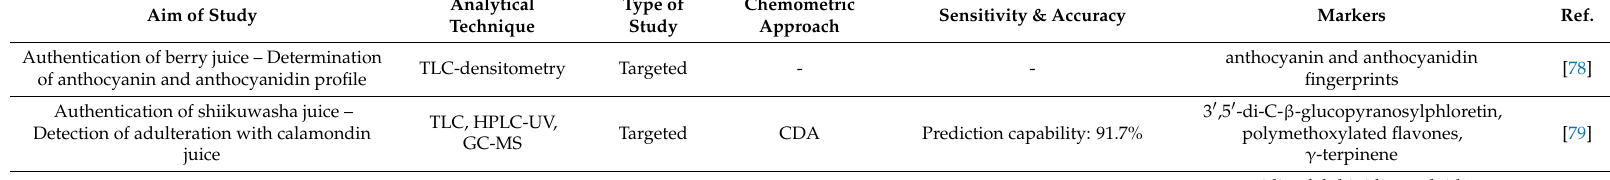
Table 4. Applications of Thin Layer Chromatography, Capillary Electrophoresis and Gas Chromatography authenticity studies of fruit